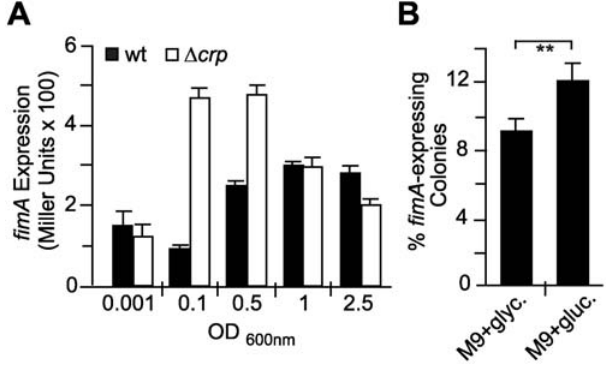
Figure 3. Type 1 fimbriae expression profile in different growth conditions. (A) fimA expression was determined by measuring ß- galactosidase activity at various optical densities from cultures of the fimA-lacZ reporter strains CBP198 (wt, black bars) and CBP199 ( D crp , white bars) in LB medium at 37 u C. (B) Quantification of the percentage of fimA -expressing cells in the population of strain CBP198 (wt) on indicator plates. Cultures were grown to mid-log phase at 37 u C in M9 minimal medium containing either glycerol (glyc.) or glucose (gluc.) as a carbon source. Mean values and standard deviations from three independent experiments are